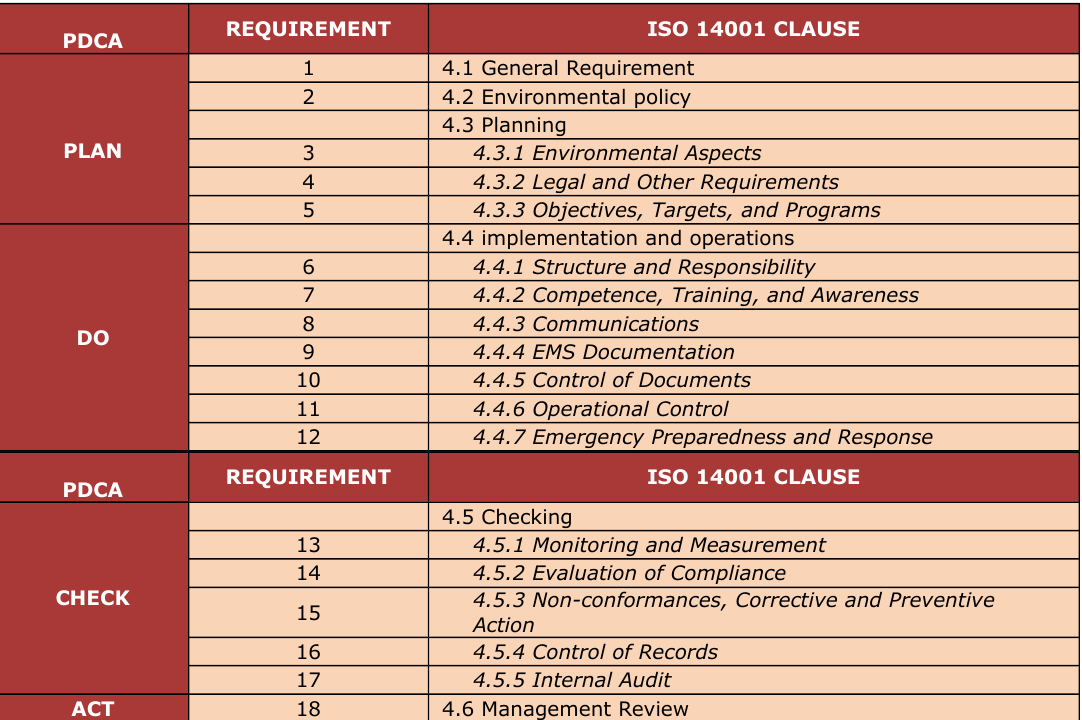
Table 3. 18 requirements of ISO14001 standard